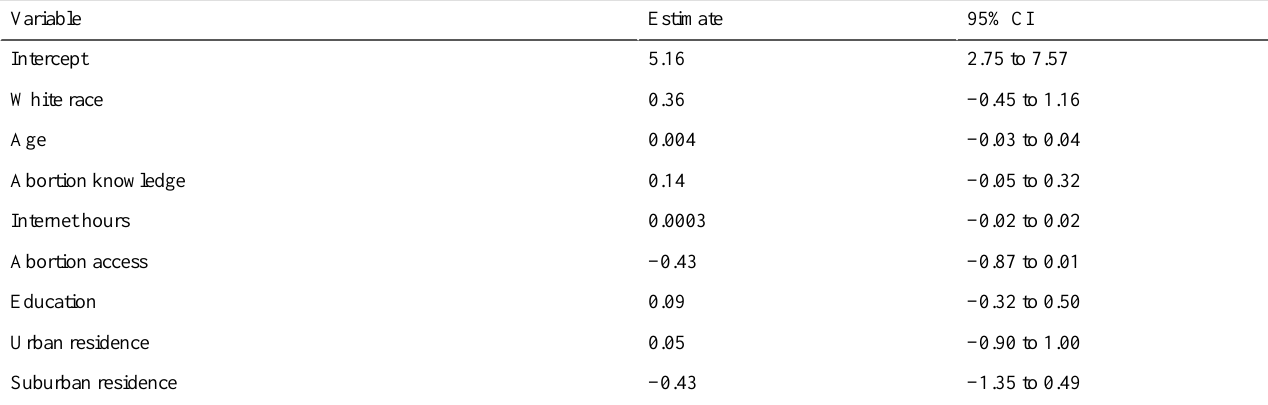
Table 7. Association between individual demographic factors and the primary outcome of mean overall trust (N=462) for the Louisiana